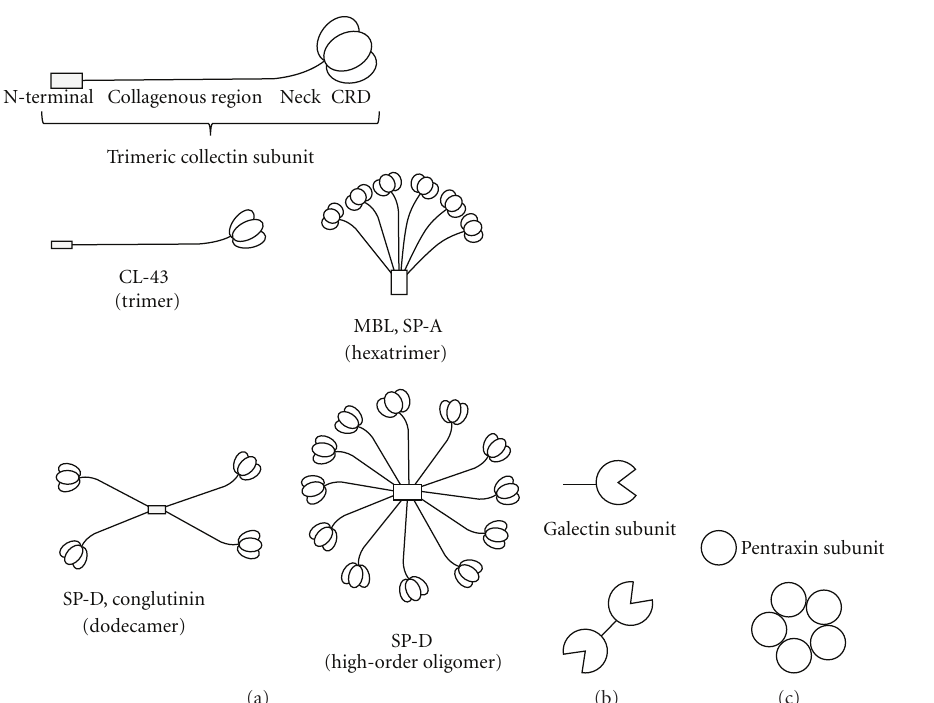
Figure 1: Subunit organization and assembly of mammalian lectins with antiviral activity against IAV. (a) Soluble C-type lectins of the collectin superfamily. Collectin subunits are comprised of 3 identical or similar polypeptide chains associated together to form triple helices. Each polypeptide chain bears a C-terminal CRD attached to a short “neck” region, a longer collagenous domain, and a noncollagenous N-terminal domain. CL-43 exists as a trimer whereas other collectins associate together to form multimers with characteristic “cruciform- like” (e.g., SP-D or conglutinin) or “bouquet-like” structures (e.g., MBL, SP-A) or higher-order oligomers (e.g., SP-D). (b) S-type lectins or galectins are a family of β -galactosidase-binding lectins containing homologous CRDs. Galectin-1 consists of a single CRD and a short N-terminal sequence and can form noncovalent dimers. (c) Pentraxin subunits are characterized by an 8 amino acid pentraxin signature (H-x-C-x-S/T-W-x-S/T, where x is any amino acid). Subunits assemble into multimers, usually noncovalently associated pentameric or decameric